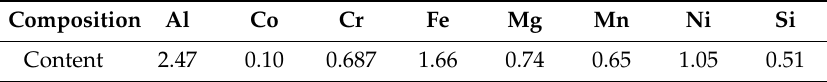
Table 4. Main chemical composition of leaching solution (g/L).